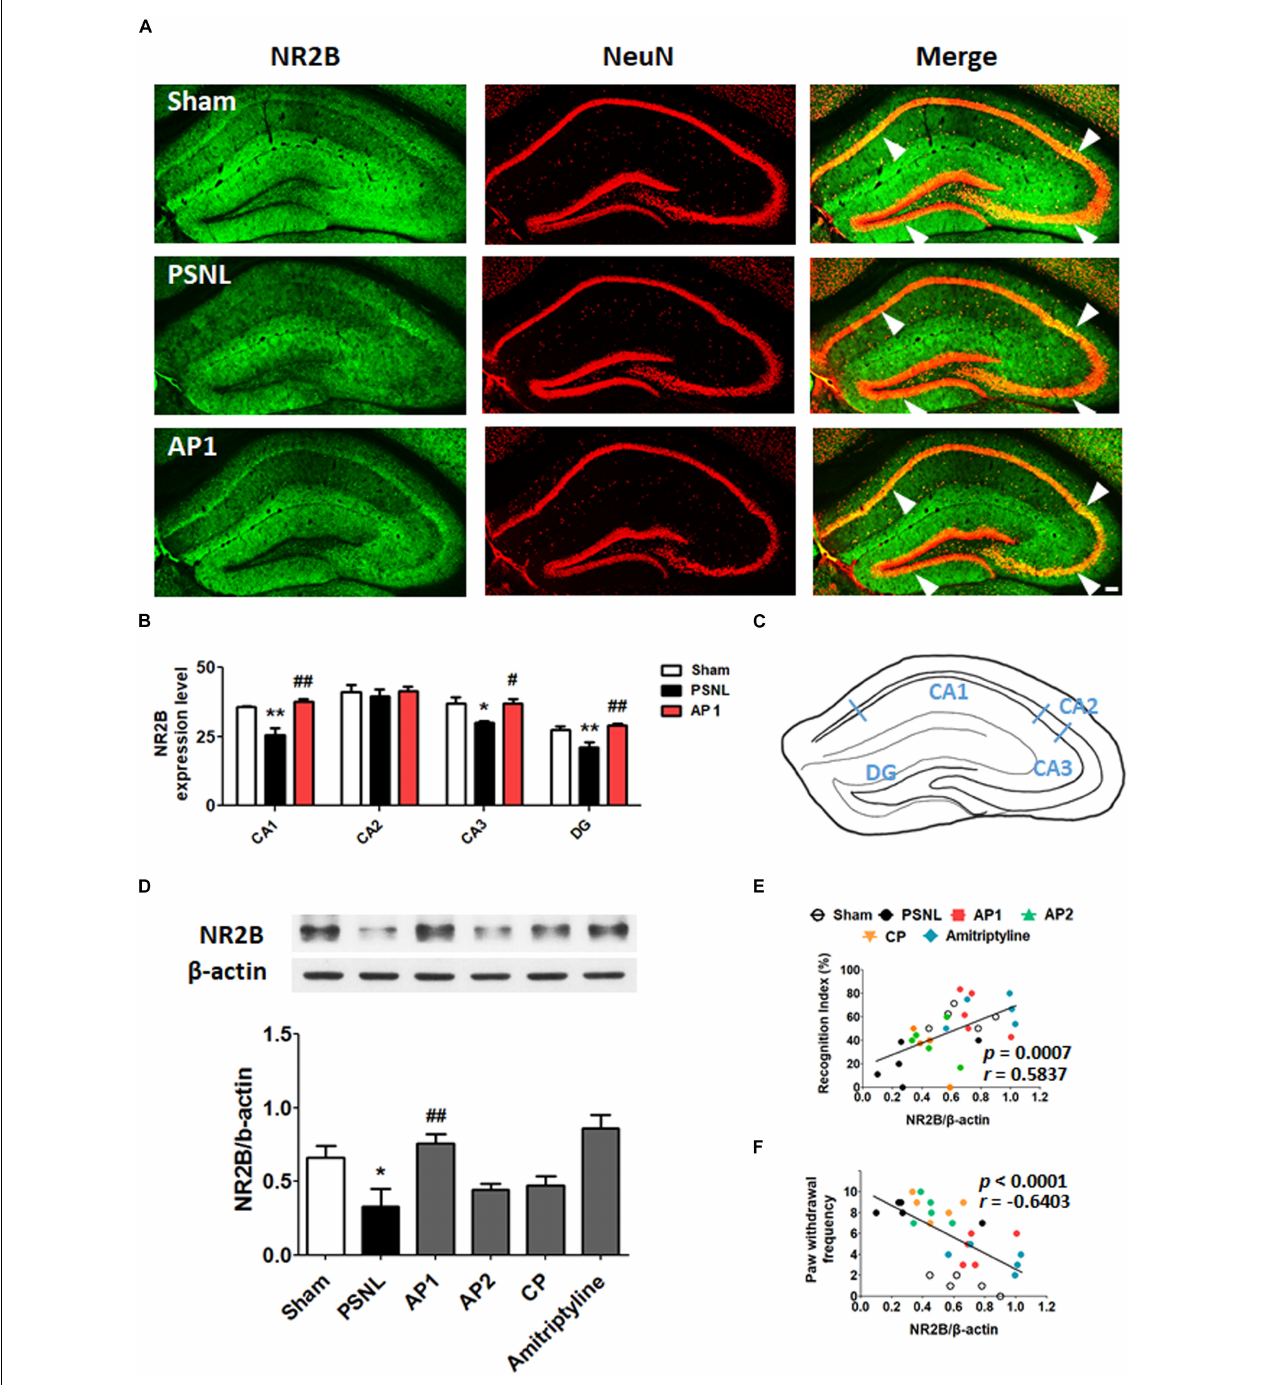
FIGURE 5 | Effects of acupuncture on the expression levels of hippocampal NR2B receptor. These results show the changes in hippocampal NR2B expression levels (CA1, CA2, CA3, and DG) after administration of acupuncture (AP1, AP2, or CP) or amitriptyline (10 mg/kg, i.p.) for 28 consecutive days (A–F) . Histological examinations of the hippocampus showing the expression of NR2B (green) and NeuN (red) after AP1 administration in the PSNL-induced neuropathic pain model (A,B) and a representative figure showing the hippocampal regions in the mouse brain (C) . n = 3–4/group. Scale bar: 100 µ m. ∗ p < 0.05, ∗∗ p < 0.01 compared to the Sham group in each area. # p < 0.05, ## p < 0.01 compared to the PSNL group in each area. The NR2B protein levels were measured in the hippocampus (D) . n = 5/group. ∗∗ p < 0.01 compared to the Sham group. # p < 0.05 compared to the PSNL group. The results were analyzed with a one-way ANOVA followed by Newman–Keuls post hoc tests. The data are expressed as the mean ± SEM. The cognitive function values in the NOR test and nociceptive values in the von Frey test were correlated with the hippocampal NR2B protein levels (E,F) . The r -values were analyzed with the Spearman rank correlation coefficient. AP1, acupuncture 1 (GB30 and GB34); AP2, acupuncture 2 (HT7 and GV20); CP, control